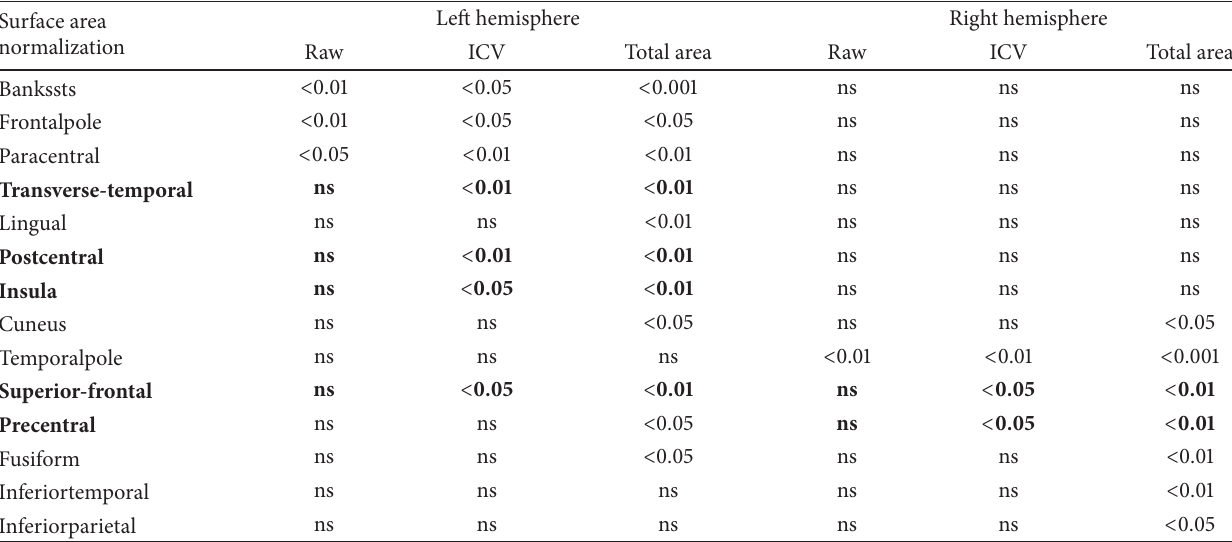
Table 7: Univariate analysis of surface area for left and right hemispheres ∗